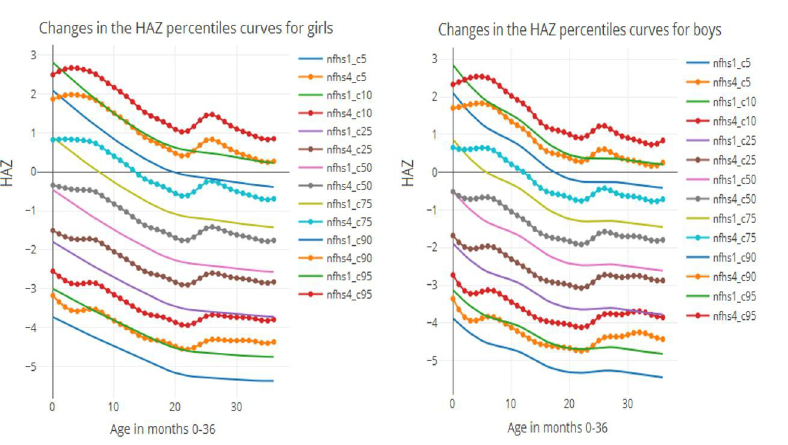
Fig 1. LMS curves for child aged 0–36 months in NFHS 1 (1992) and NFHS 4